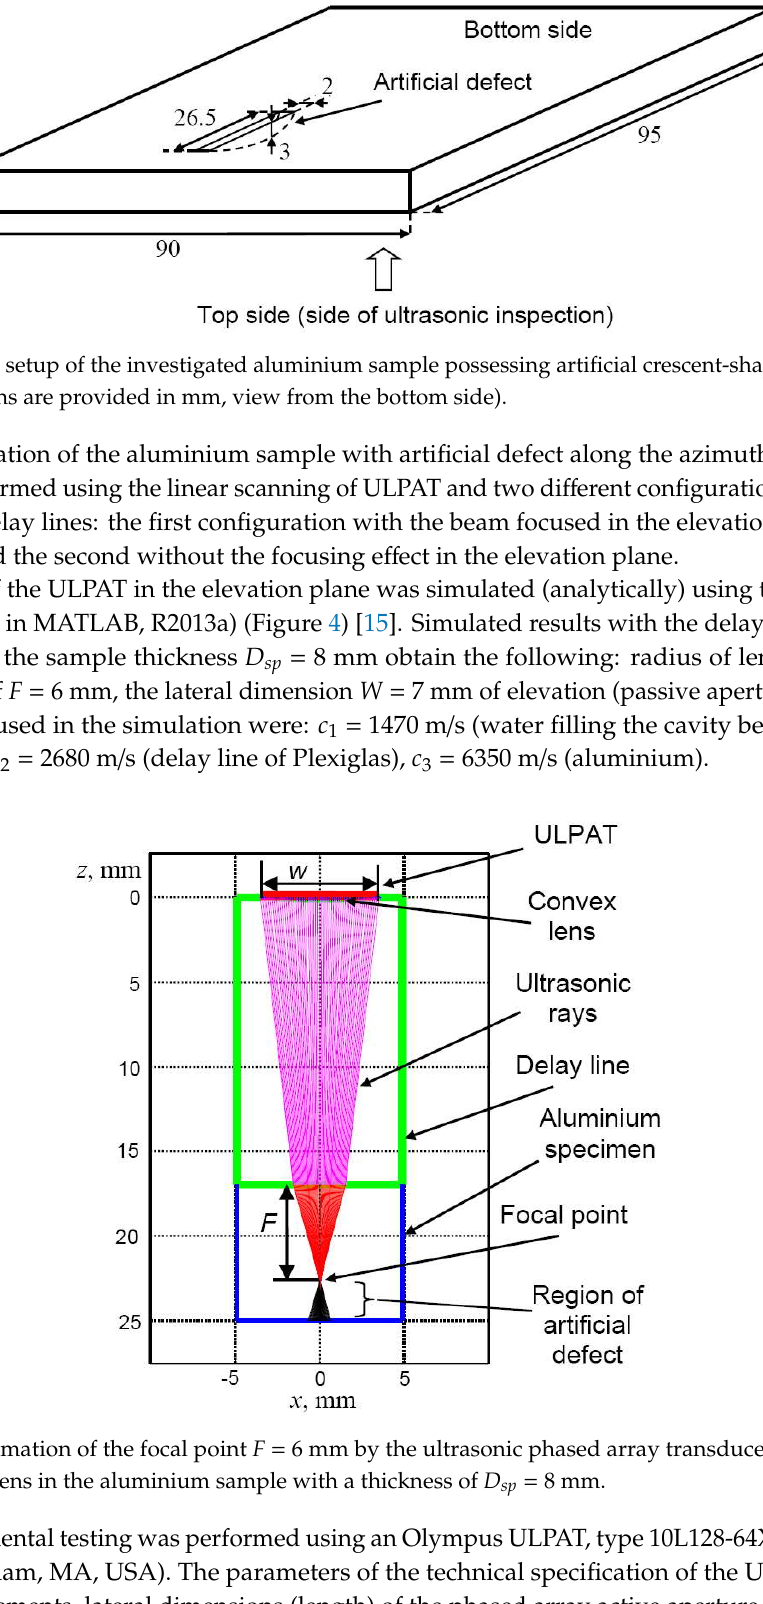
Figure 4. Estimation of the focal point F = 6 mm by the ultrasonic phased array transducer (ULPAT) with convex lens in the aluminium sample with a thickness of D sp = 8 mm.